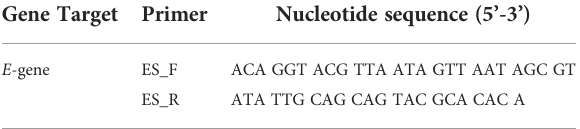
TABLE 1 Primers used in qPCR analysis of SARS-CoV-2